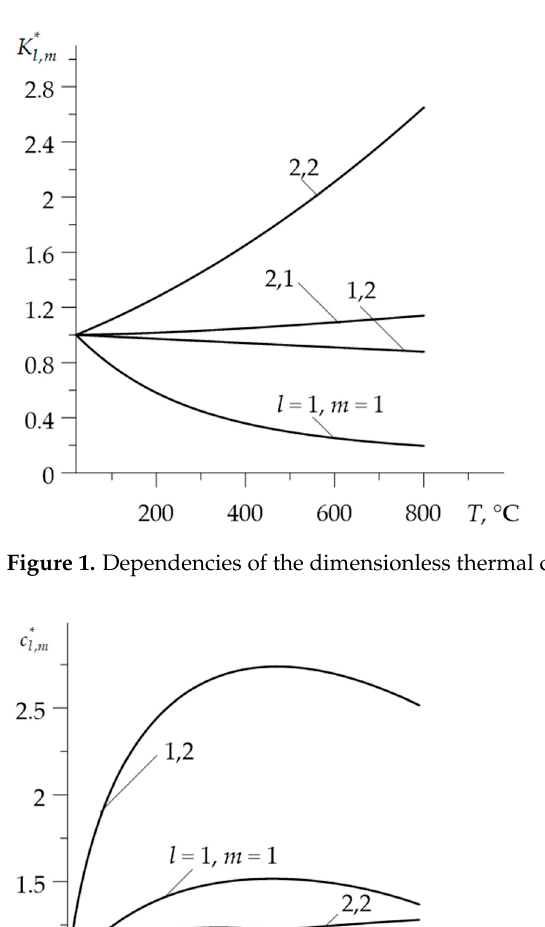
Materials 2022 , 15 , 963 9 of 16